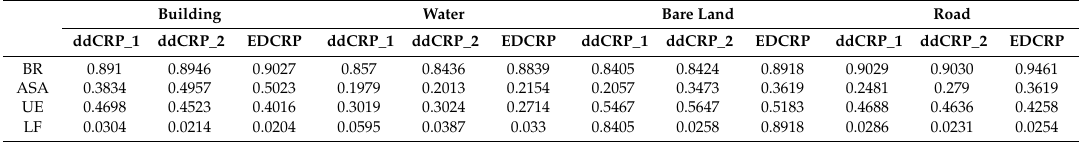
Table 3. The quantitative evaluation of Table 2. The quantitative evaluation of over-segmentation.